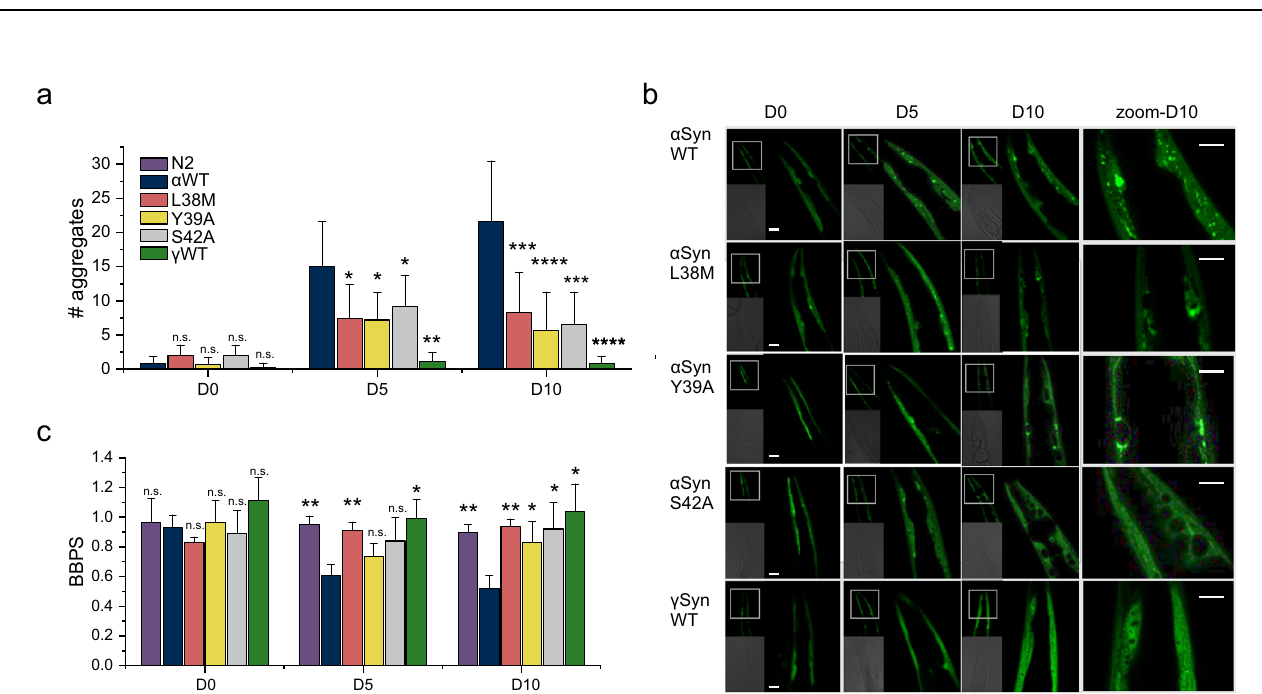
Fig.9. The insets showrepresentative TEM images of each sample taken attheend of the reaction (110h) of one biological replicate ( n =2). % pellet are shown in Supplementary Table 1e. Source data are provided as a Source Data fi le.